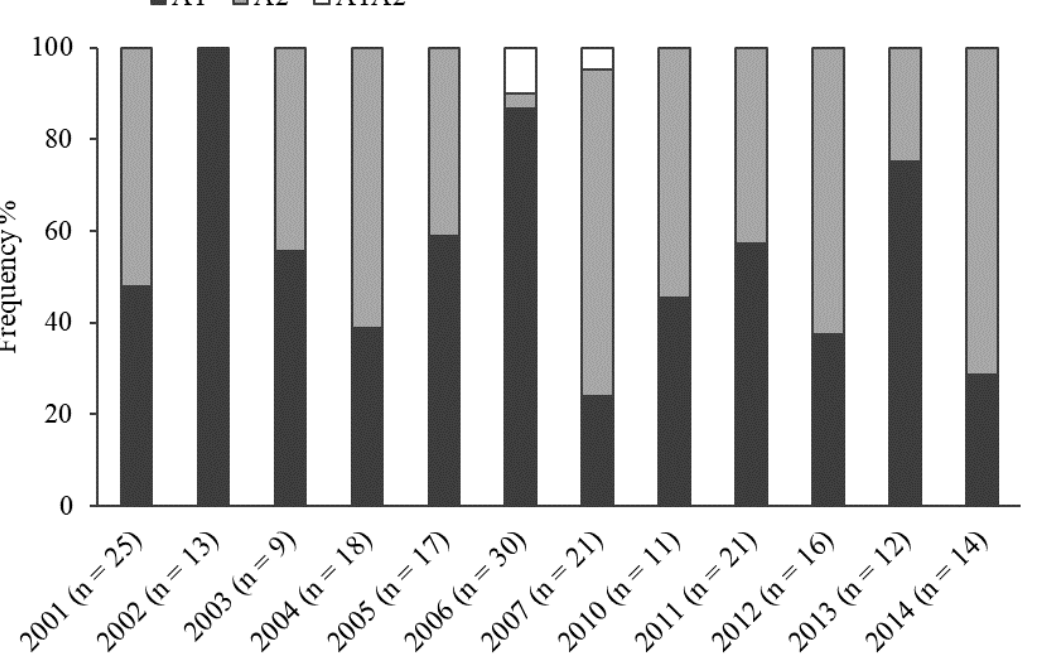
Figure 1. Frequency of mating types among isolates of Phytophthora infestans from potato ( Solanum tuberosum ) breeding fields in Estonia during 2001–2007 and 2010–2014. n is the total number of isolates assessed for mating type in each year.